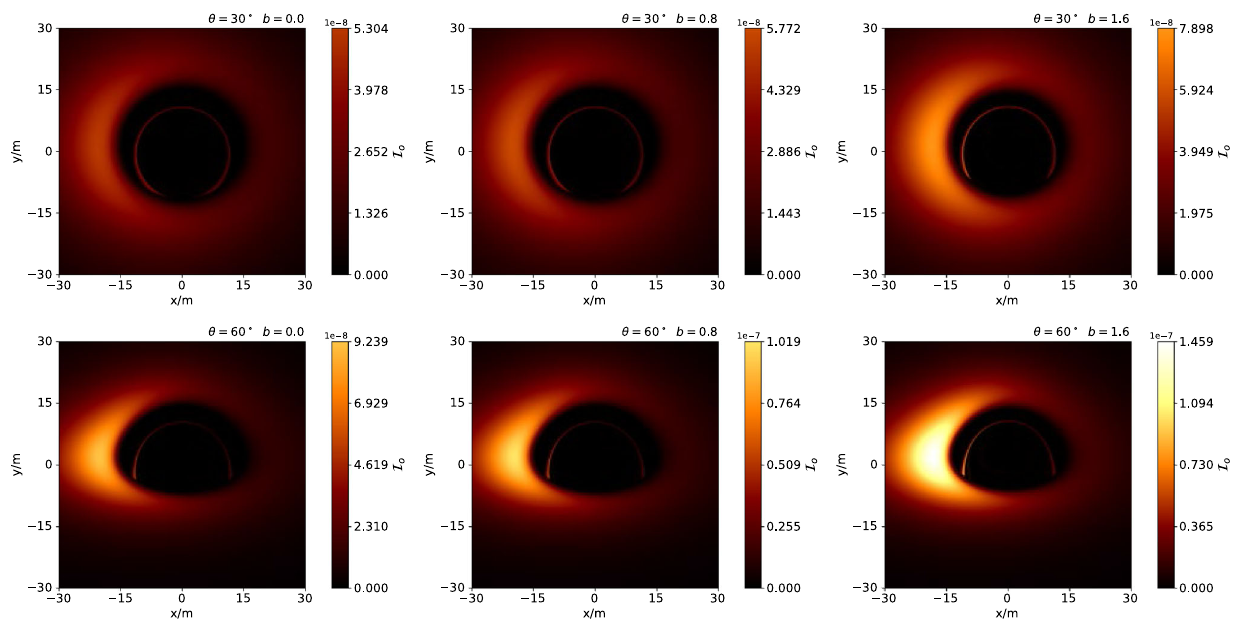
Fig. 1 Image of Bonnor black dihole surrounded by a thin accretion disk withdifferent magneticdipole parameter b for the fixed r 0 = 1000. The upper row is for the observer’s inclination angles θ 0 = 30 ◦ and the Fig. 2 Image of Schwarzschild black hole surrounded by a thin accretion disk. The mass of Schwarzschild black hole here is set to the same as that of Bonnor black dihole in Fig.